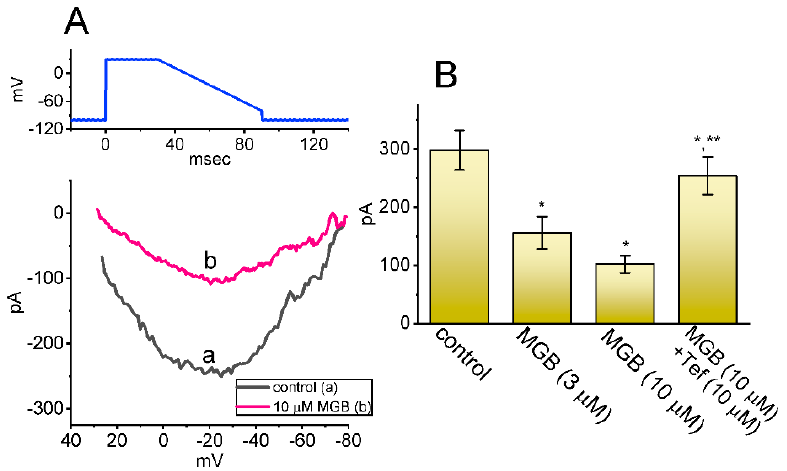
Figure 6. Effect of MGB on resurgent I Na ( I Na(R) ) evoked by the descending V ramp . The tested cell was held at − 100 mV and the 30 ms depolarizing pulse at +30 mV was applied. Following the step depolarization, the downsloping V ramp from +30 to − 80 mV was delivered to the cell for a duration of 60 ms. ( A ) Representative I-V relationships of I Na(R) evoked by the descending V ramp in the absence (a, black) and presence (b, pink) of 10 µ M MGB. The upper part signifies the voltage protocol used, and the x -axis at the lower part is indicated from +40 to − 80 mV. ( B ) Summary bar graph showing effects of MGB and MGB plus tefluthrin (Tef) on I Na(R) (mean ± SEM; n = 7 for each bar). Current amplitude was measured at the level of − 20 mV during the descending V ramp . * This result is significantly different from control ( p < 0.05) and ** significantly different from the MGB (10 μ M) alone group ( p < 0.05).